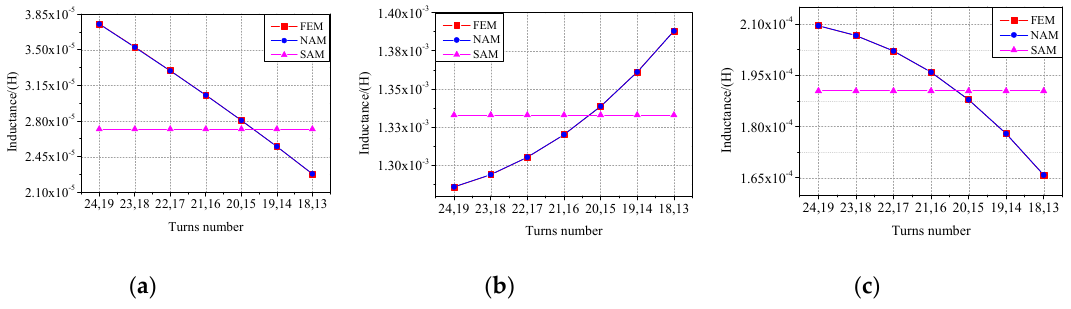
Figure 10. The inductances of the faulty coil when there are two turns shorted in layer 2: ( a ) self-inductance in faulty part; ( b ) self-inductance in healthy part; ( c ) mutual inductance.